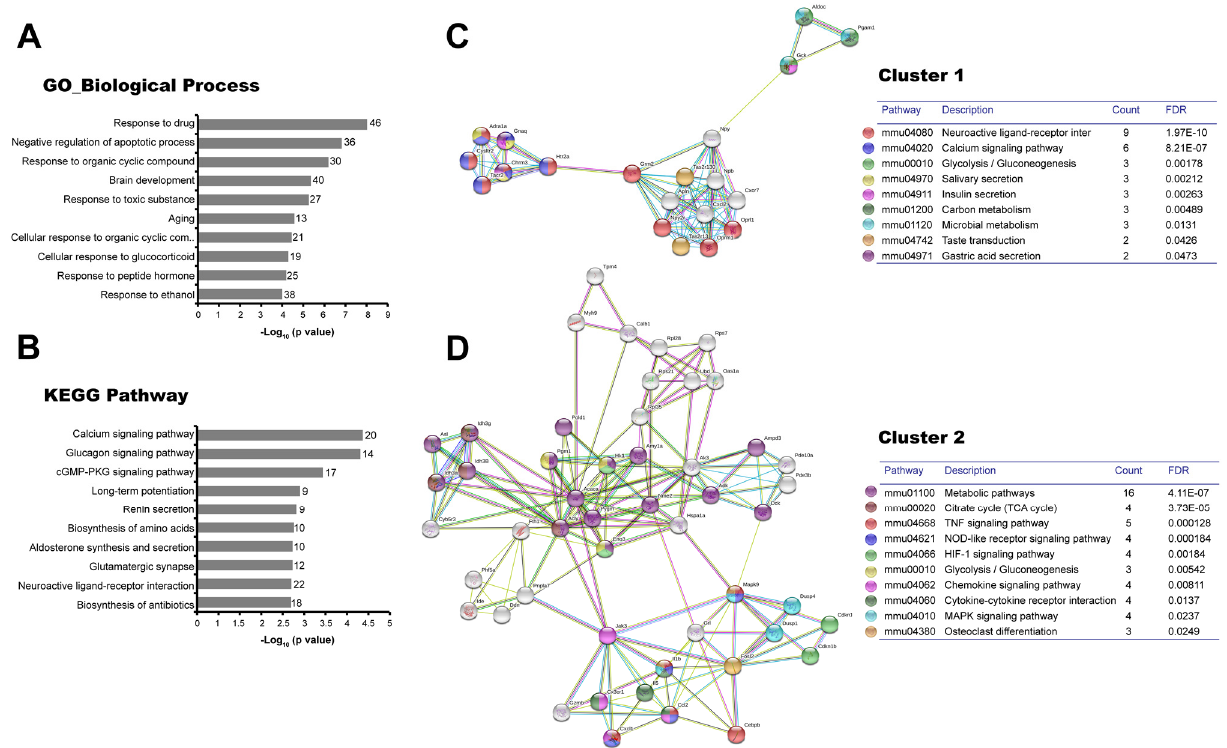
Figure 1. Transcriptomic dysregulation in hind paw footpads at 24 h post-Complete Freund’s Adjuvant injection. The lists of the differentially expressed genes (Z-score ≥ 1.5 SD) by CFA at 24 h were analyzed on the DAVID Bioinformatics Resources 6.8 (https://david.ncifcrf.gov/ accessed on 10 January 2023; ( A , B )), STRING 11.5 database (https://string-db.org/ accessed on 10 January 2023) and Cytoscape 3.9.1 platforms ( C , D ). The top 10 Gene Ontology (GO) Biological Process ( A ) and the Kyoto Encyclopedia of Genes and Genomes (KEGG) pathways ( B ) resulting from the DAVID database are shown in bar charts indicating the − Log10 ( p -value) of each GO and KEGG term. The number of genes involved in each term is shown on the right side of each bar. From the protein-protein interactions network of deregulated genes, the first ( C ) and second ( D ) clusters of sub-networks were obtained using the Molecular Complex Detection (MCODE) complement (cutoff = 0.4). The KEGG signaling pathways relevant to arthritis were selected (Tables) and marked with different colors. Line color indicates the type of interaction evidence. FDR: False discovery rate.